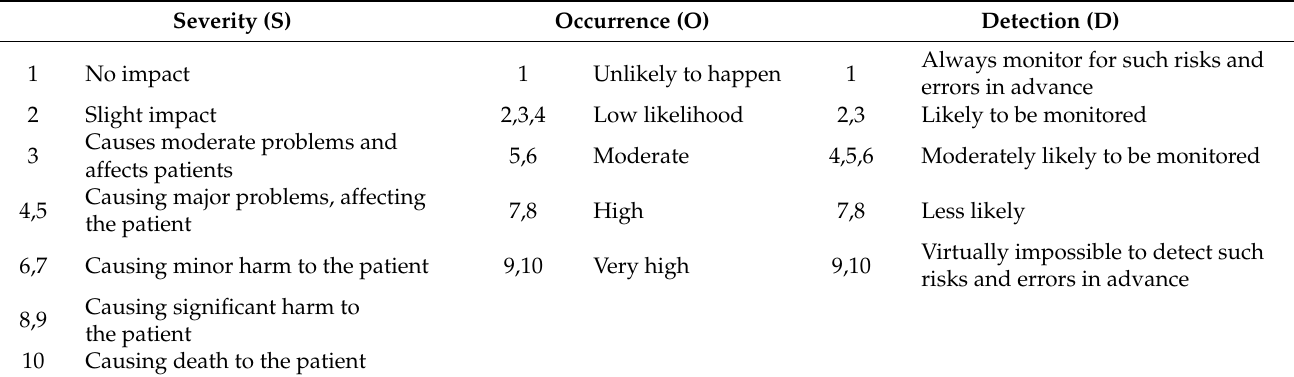
Table 1. FMEA scoring